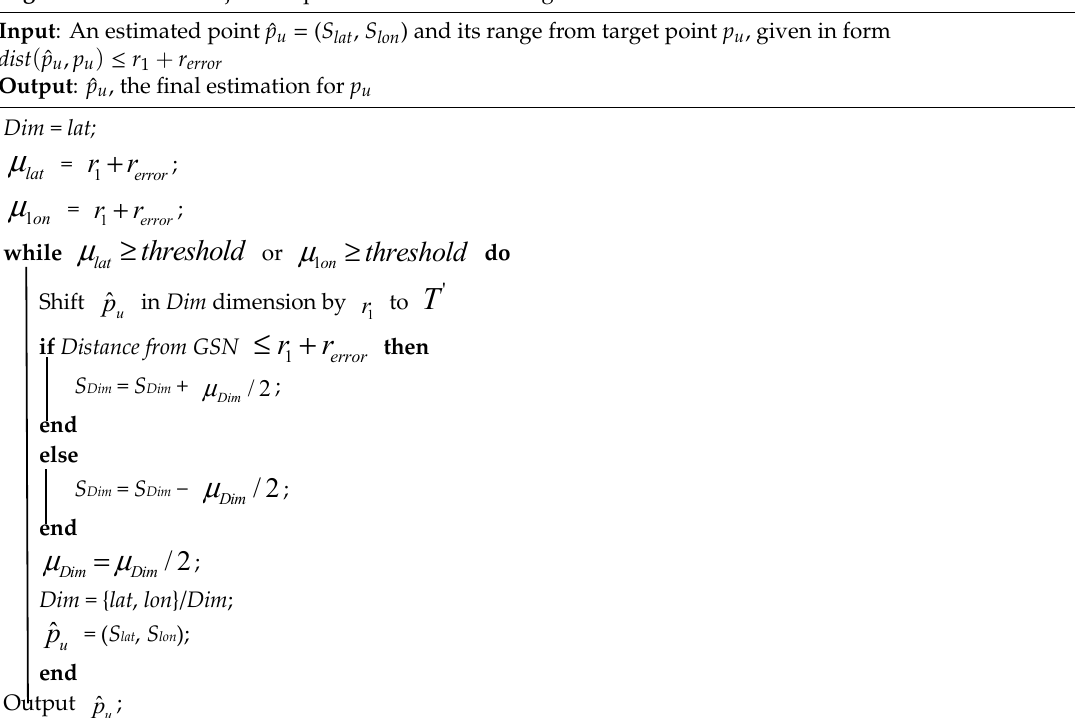
Table 1. The Pseudo-code of Error-Adjusted Space Partition Attack Algorithm. Error-Adjusted Space Partition Attack Algorithm Algorithm 1. Error-Adjusted Space Partition Attack Algorithm